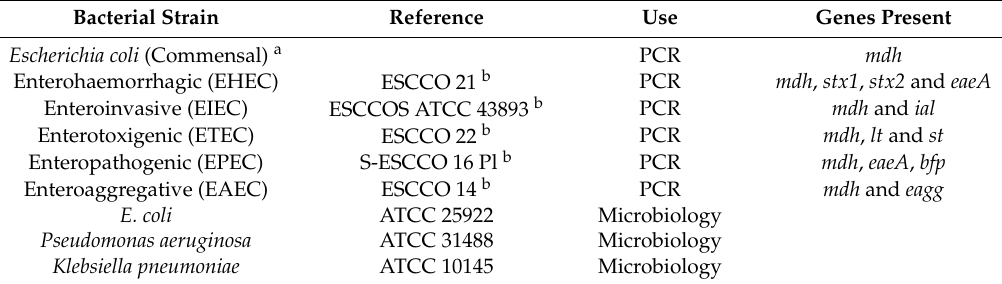
Table 2. Bacterial strains used in molecular characterization